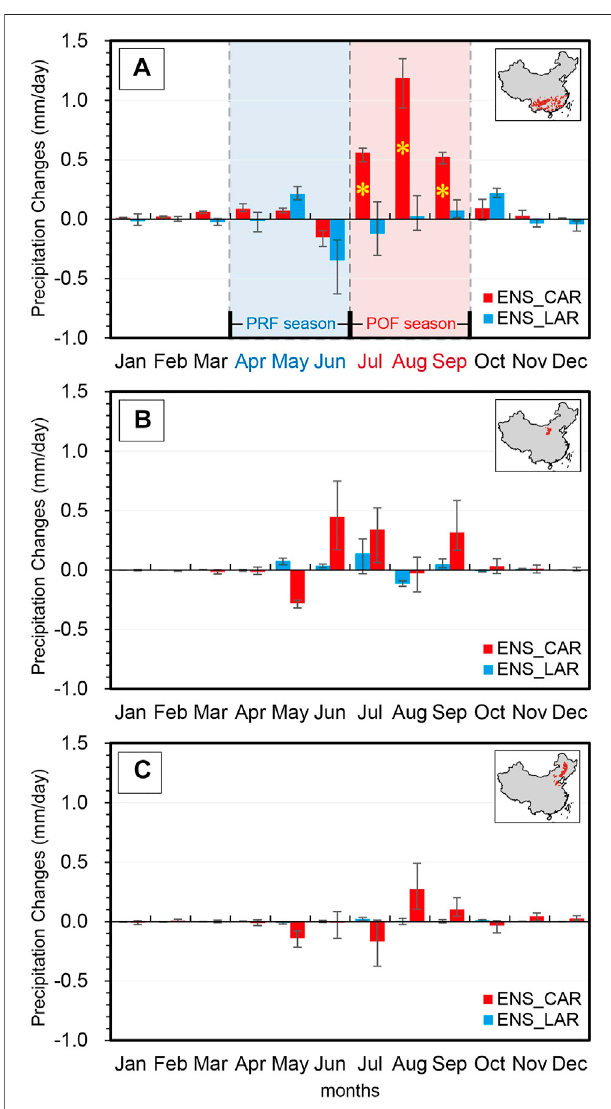
FIGURE 4 | The multi-year mean monthly variations of the regional averaged realistic LUCC-induced changes in afternoon convective (red, “ CAR ” ) and large-scale (blue, “ LAR ” ) rainfall (units: mm/day) for three typical LUCC regions: (A) cropland-to-forest transitions in southern China, (B) bare ground-to-grassland transitions in Hetao region and (C) the grassland- to-cropland transitions in northeastern China. Note that the grids involved in the regional mean calculation are shown in the subplots in the top right corner of each fi gure. The bars with yellow asterisks inside indicate a greater than “ moderate ” degree of consistency among the results of the ensemble members. Error bars denote ensemble spread of the changes.